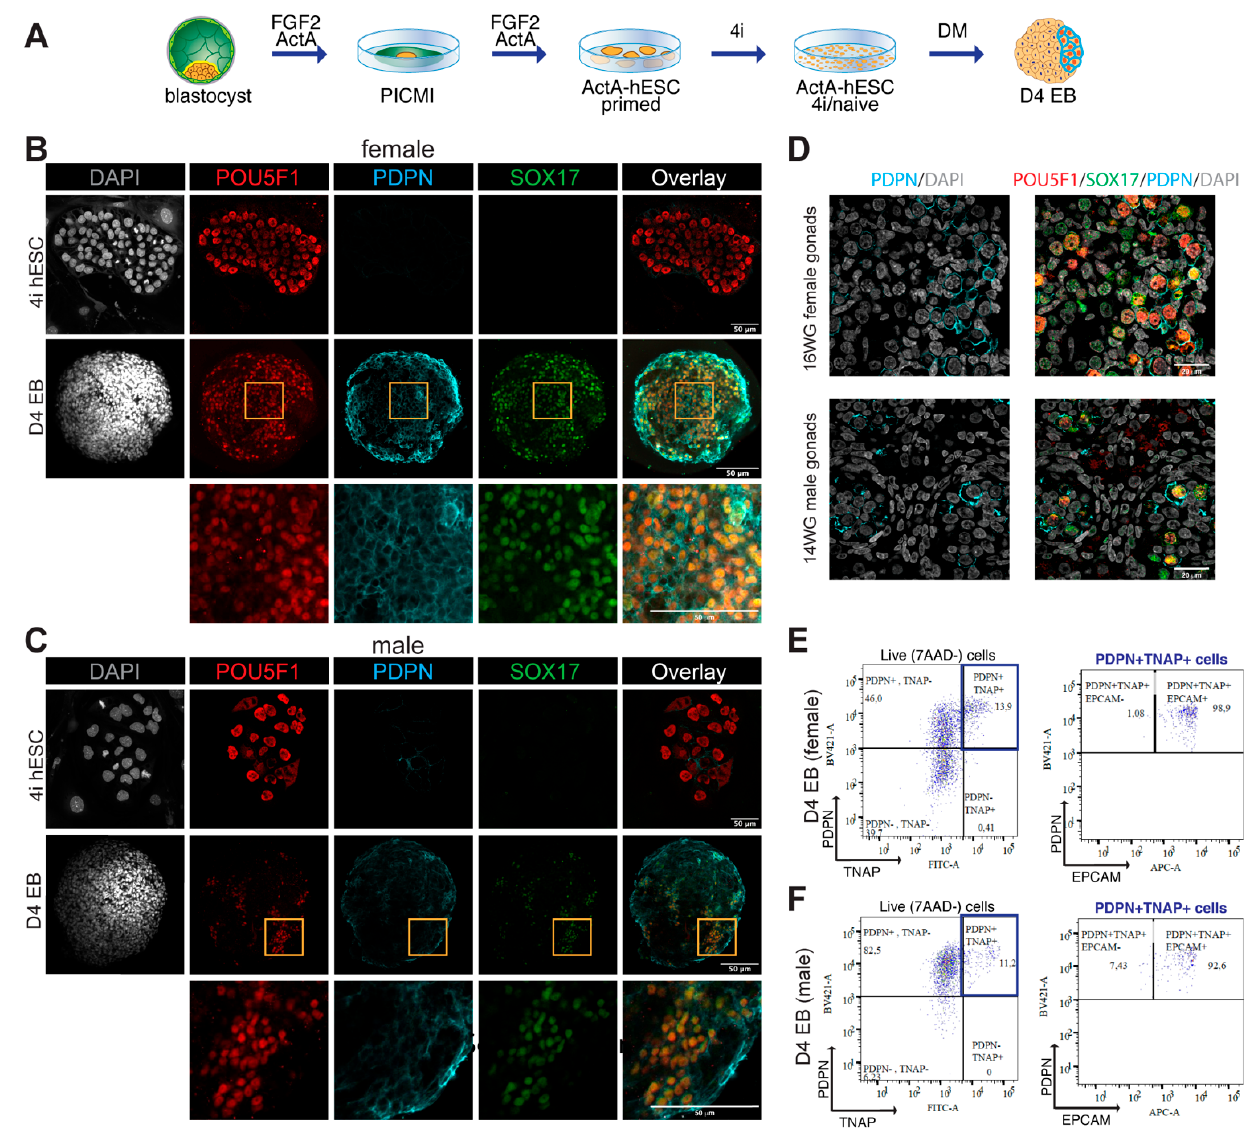
(right). The individual percentages are given (black circles) as well as mean±standard deviation. ( E ) FACS plots showing (bottom panel) are shown for the PDPN/TNAP high (Hi) and low (Lo) populations. ( F ) FACS plots showing expression of are shown for the PDPN/TNAP high (Hi) and low (Lo) populations.